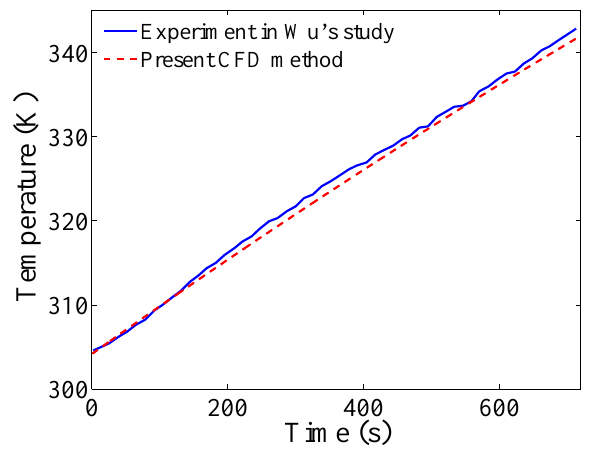
Figure 6. Comparison of the numerical results of the present study and the experiment data in the